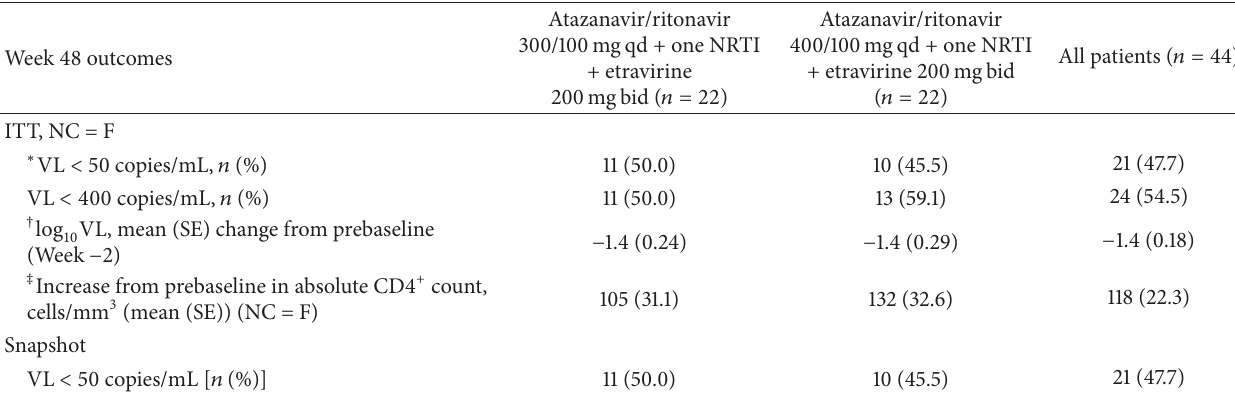
Table 5: Virologic and immunologic outcomes at Week